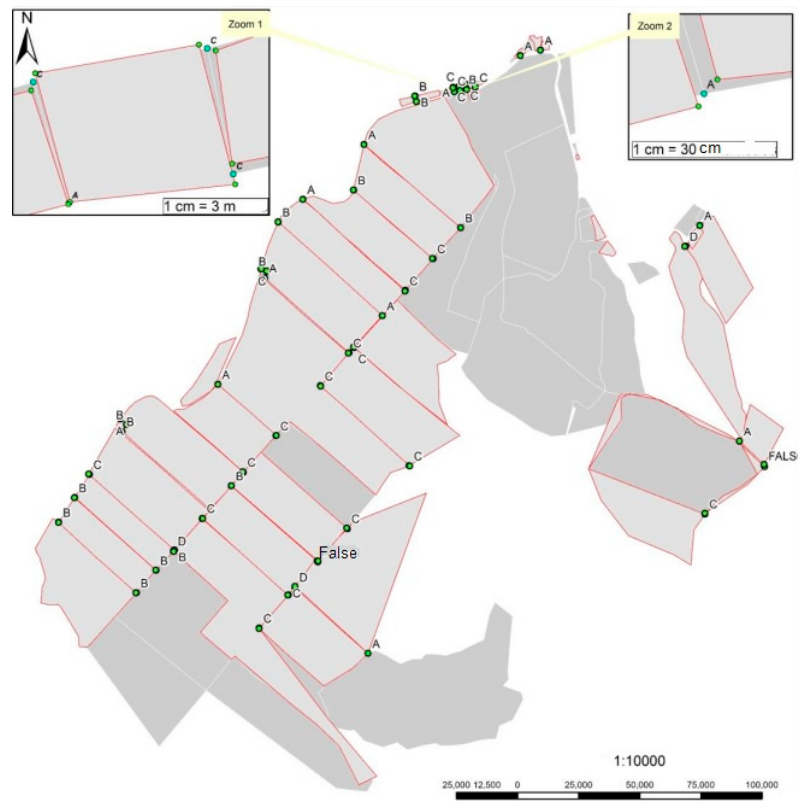
Figure 7. Point distribution in the dataset and classification.